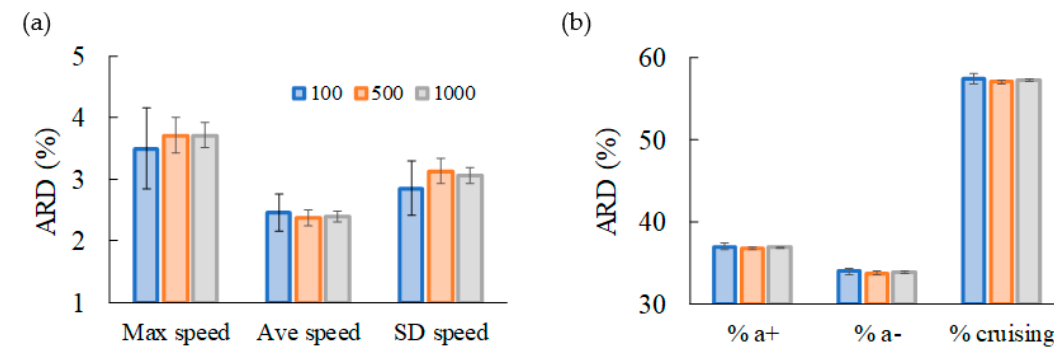
Figure 4. ARDi and their confidence intervals for some CPs with different number of runs. ( a ) Speed related CPs when applied MT. ( b ) Operation mode related CPs when applied MCMC.